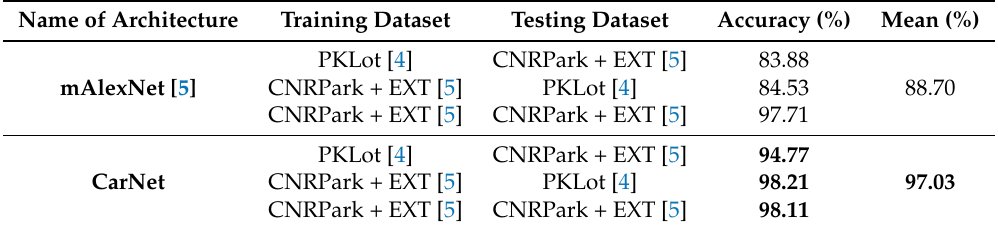
Table 14. Comparison of testing results of CarNet and mAlexNet [5] on PKLot [4] and CNRPark + EXT datasets